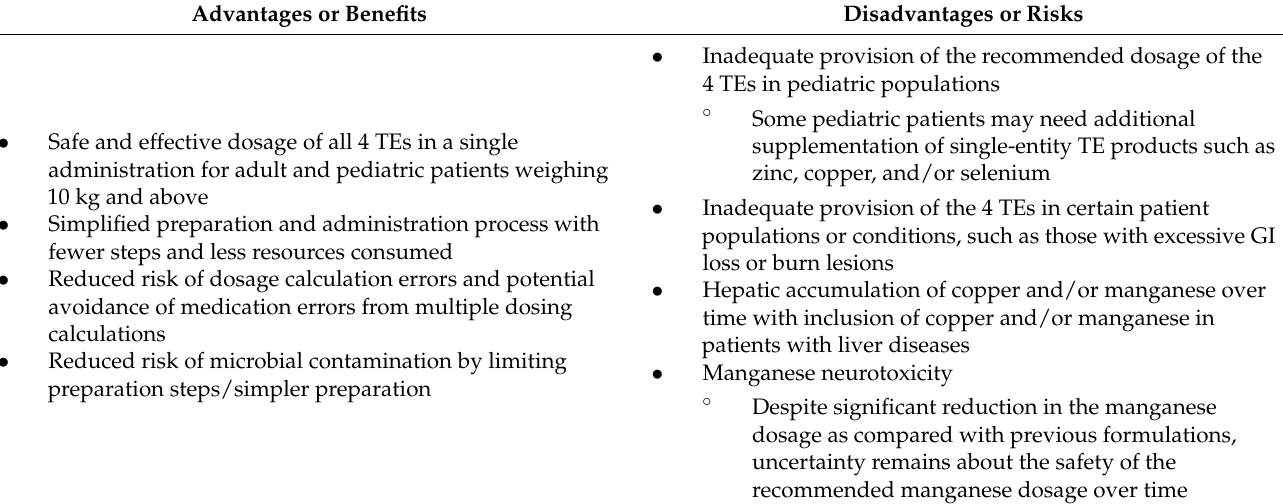
Table 4. Benefits and potential risks associated with using multi-trace element (TE) products versus multiple individual TE products for parenteral nutrition formulations a